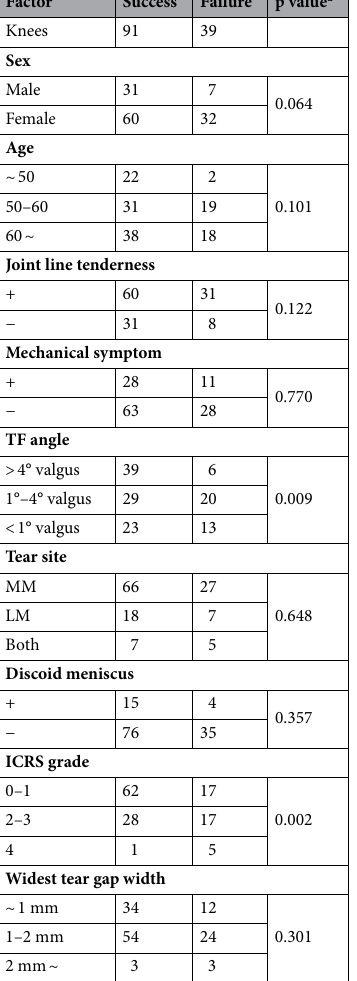
Table 1. Single variable analysis results of factors to the failure of non-surgical treatment. a Pearson’s chi- square test. TF angle tibiofemoral angle (joint alignment on the simple posteroanterior radiograph), MM medial meniscus, LM lateral meniscus, ICRS International Cartilage Repair